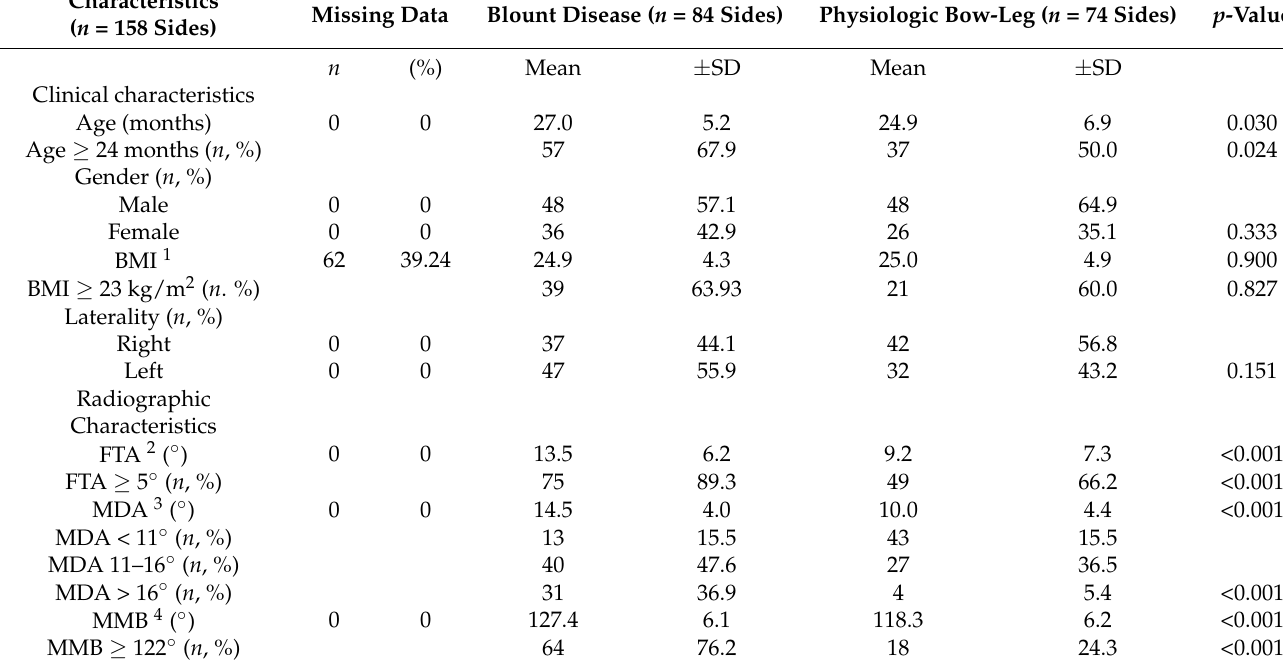
Table 2. Demographic and clinical characteristics of the 158 lower extremities from 79 patients compared between those with Blount’s disease and those with physiologic bowlegs.